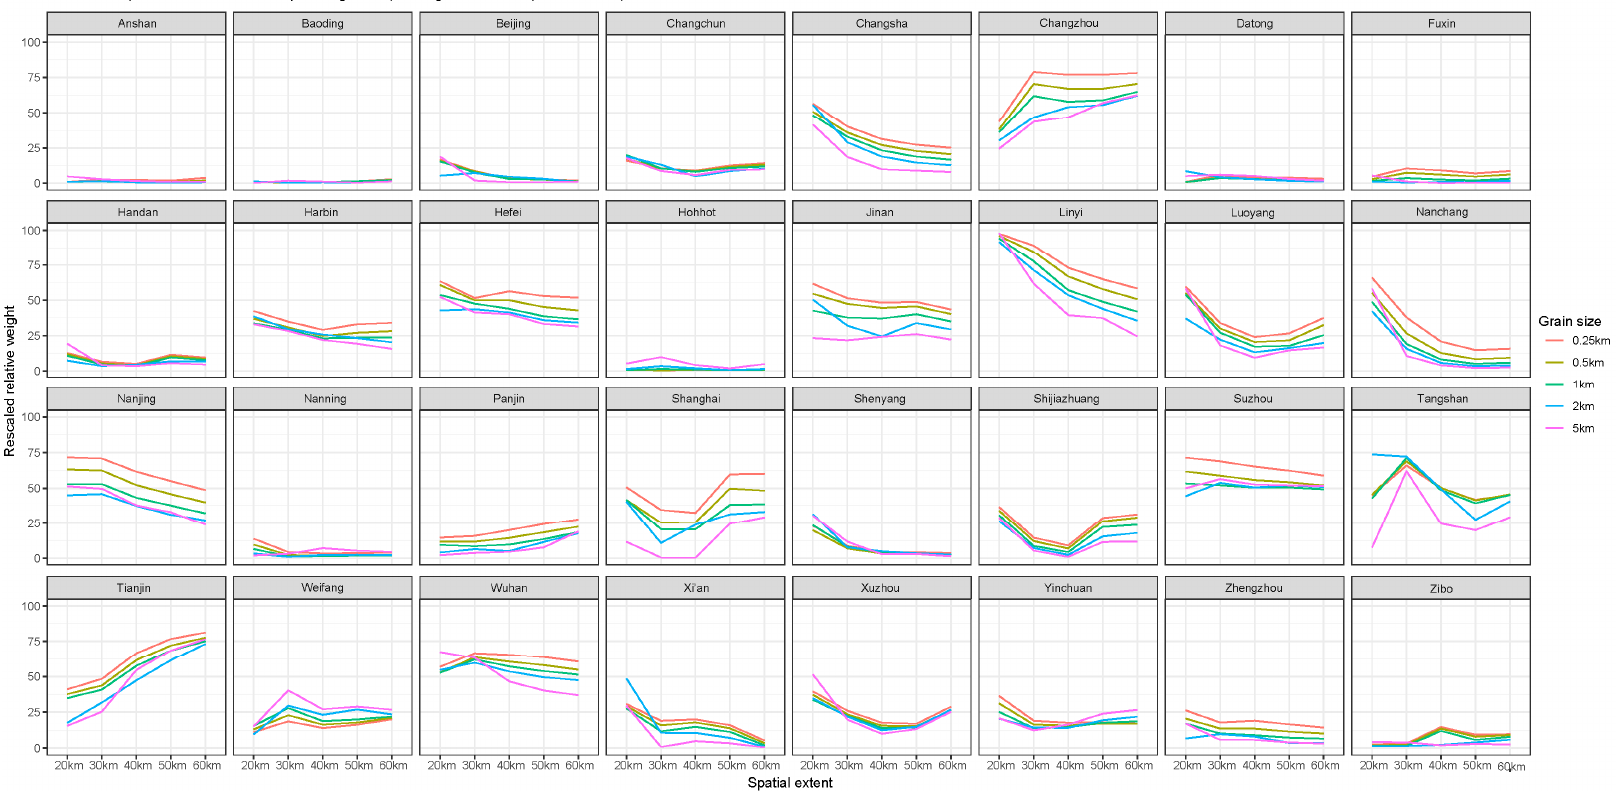
Figure A17. Relative importance of WC for explaning LST(Scalogram of the spatial extent).